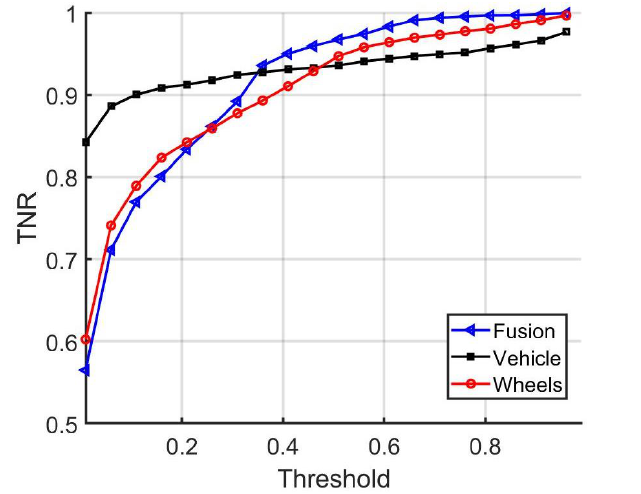
Figure 13. Comparison of the baseline, vehicle, and wheel-network-matching true negative